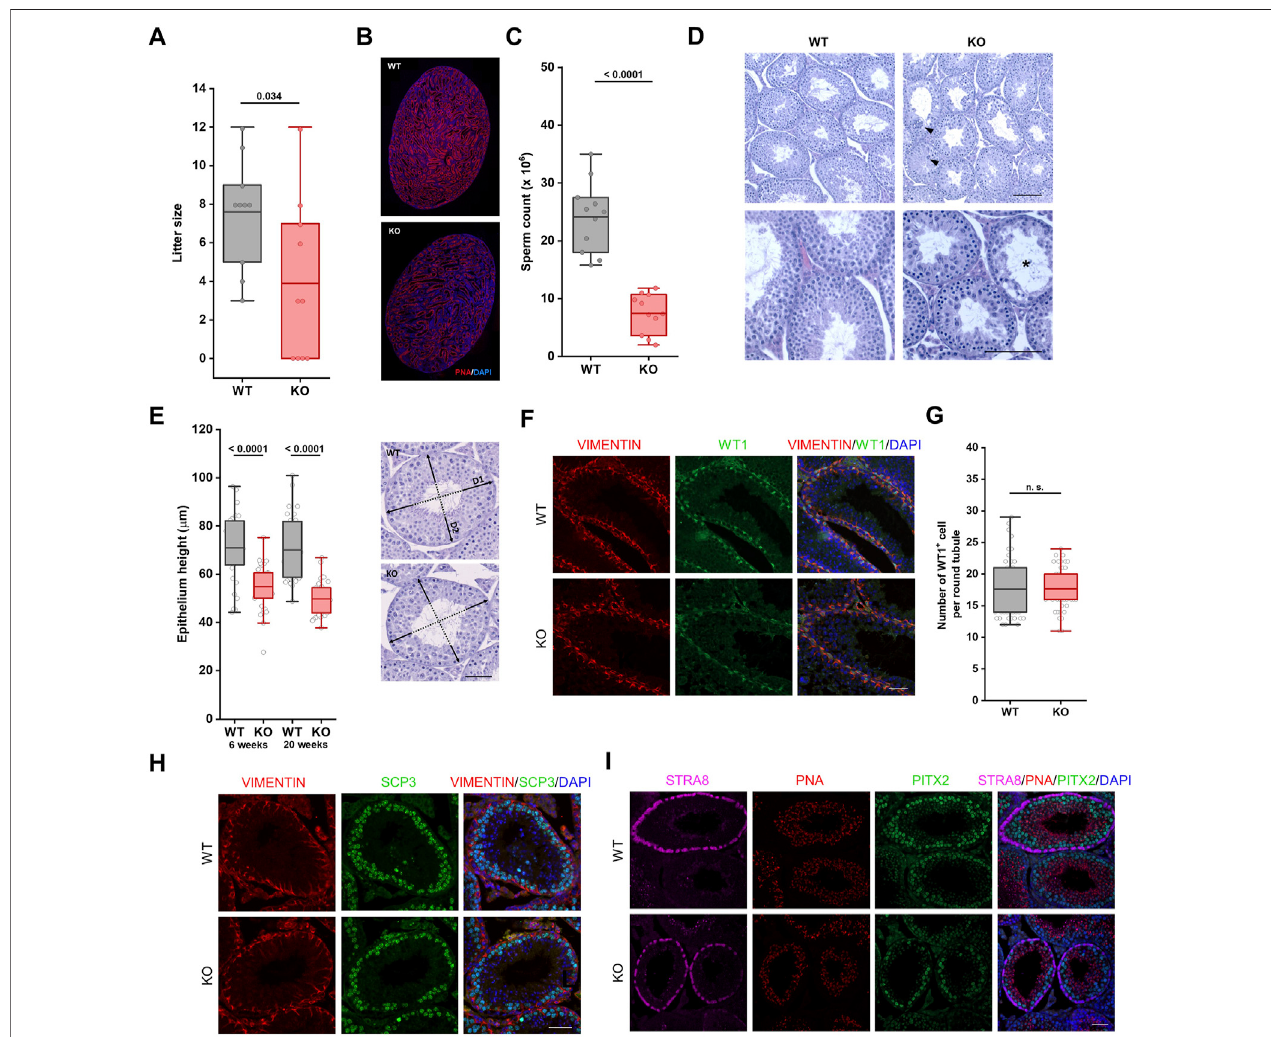
FIGURE 2 | Reproduction and spermatogenesis are impaired in Fbxo38 -de fi cient animals. (A) Litter size of WT females bred to Fbxo38 WT or KO males. Litters wererecordedforthetimeperiod of18 – 21 daysaftermonitored vaginalplugs.Numberofpupsperlitterareshownasindividualdatapoints, horizontalbarsshowmean values,boxes represent the25thand 75thpercentiles.Statistical signi fi cance wasassessed byanunpaired two-tailed t -test. (B) Compositepicturesofsagittal sections of Fbxo38 WT and KO testes labeled with peanut agglutinin (PNA) lectin and counterstained with DAPI. (C) Sperm counts of adult (17 – 21 weeks) Fbxo38 WT and KO males with the same age distribution in both groups. Spermatozoa were isolated from both caudae epididymides. Individual data points are shown, horizontal bars show mean values, boxes represent the 25th and 75th percentiles. Statistical signi fi cance was assessed by an unpaired two-tailed t -test. (D) Hematoxylin and eosin- stained testicular sections from 9-week-old Fbxo38 WT and KO males. Arrowheads point to atypical multinucleated cells, asterisks show disrupted tubules. Scale bar, 100 µm. (E) Height of germinal epithelium from young and adult Fbxo38 WT and KO animals (left) and methodological approach of measurement (right). Average height of germinal layer in two perpendicular axes was measured for each tubule (35 randomly selected round tubules from transversal section per animal). Horizontal bars show mean values, boxes represent the 25th and 75th percentiles. Statistical signi fi cance was assessed by an unpaired two-tailed t -test. Scale bar, 50 µm. (F) Seminiferous tubule sections of young adult (10 weeks) Fbxo38 WT and KO mice stained for Vimentin and WT1. DNA was visualized with DAPI. Scale bar, 50 µm. (G) The number of WT1-positive cells in round seminiferous tubules from sections of Fbxo38 WT and KO testes ( n = 2; 24 tubules per animal). Horizontal bars show mean values, boxes represent the 25th and 75th percentiles. Statistical signi fi cance was assessed by an unpaired two-tailed t -test. (H) Seminiferous tubule sections of young adult(10 weeks) Fbxo38 WTandKOmicestainedforVimentinandSCP3.DNAwasvisualizedwithDAPI.Scalebar,50 µm. (I) Seminiferoustubulesectionsof17-week- old Fbxo38 WT and KO mice co-stained with antibodies against STRA8 and PITX2 and labeled with PNA. DNA was visualized using DAPI. Scale bar, 50 µm.